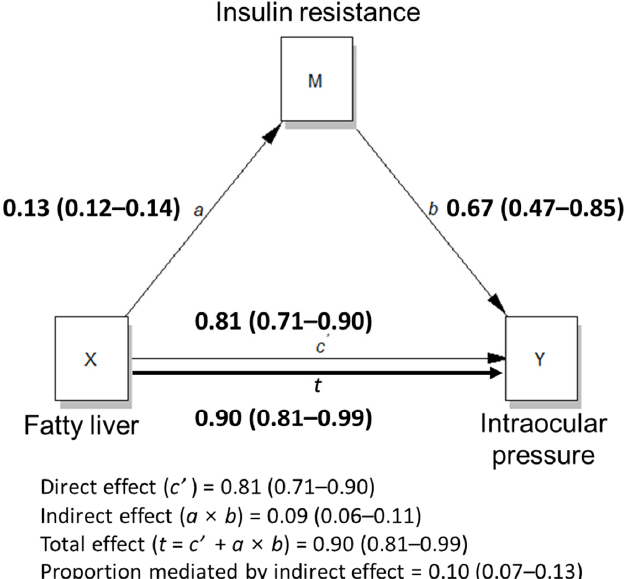
Figure 4. Mediation analysis on the effect of fatty liver on intraocular pressure. a , b and c’ are path coefficients representing unstandardized regression weights and 95% confidence interval. c’ , direct effect; a × b , indirect effect; t , total effect; X, dependent variable; M, mediator variable; Y, independent variable; IOP, intraocular pressure.